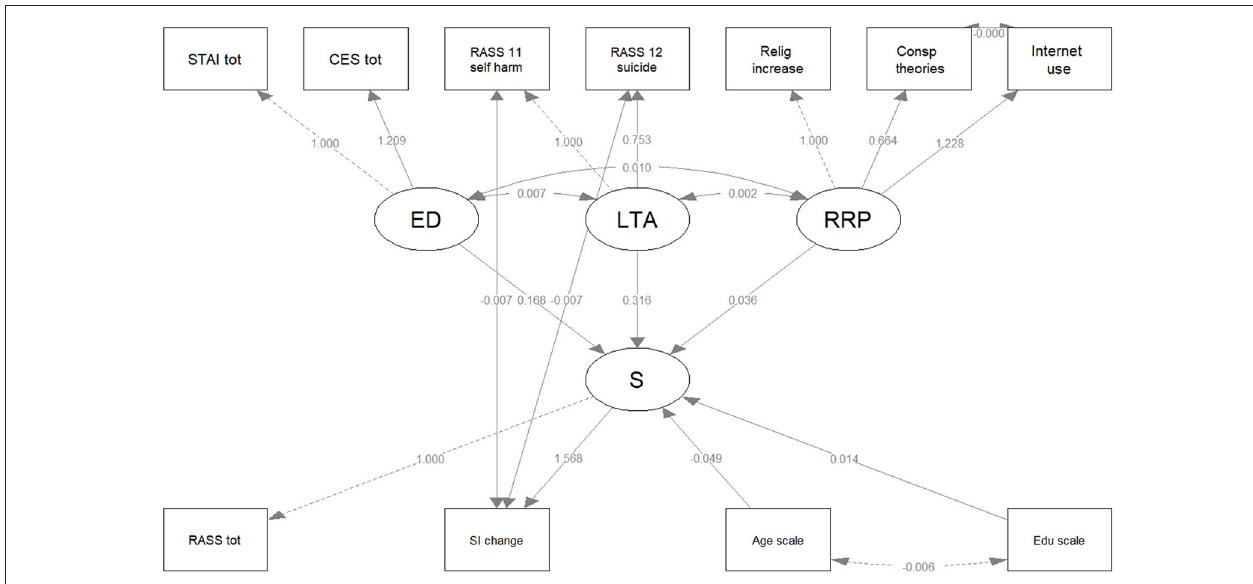
FIGURE 3 | The path diagram for the SEM Model 3. Latent variables are drawn in circles and manifest variables are drawn in squares. The edge labels indicate the parameter estimates. CES tot, Center for Epidemiologic Studies Depression Scale (CES-D), 20-item total; ED, Emotional Disturbances; LTA, Life Threatening Attempts; RASS 11 self-harm, 4-point score of RASS 11; RASS 12 suicide, 4-point score of RASS 12; RASS tot, Risk Assessment Suicidality Scale (RASS), 10-item total; S, Suicidality; SI change, Suicidal Ideation change; STAI tot, State-Trait Anxiety Inventory (STAI), 20-item total.